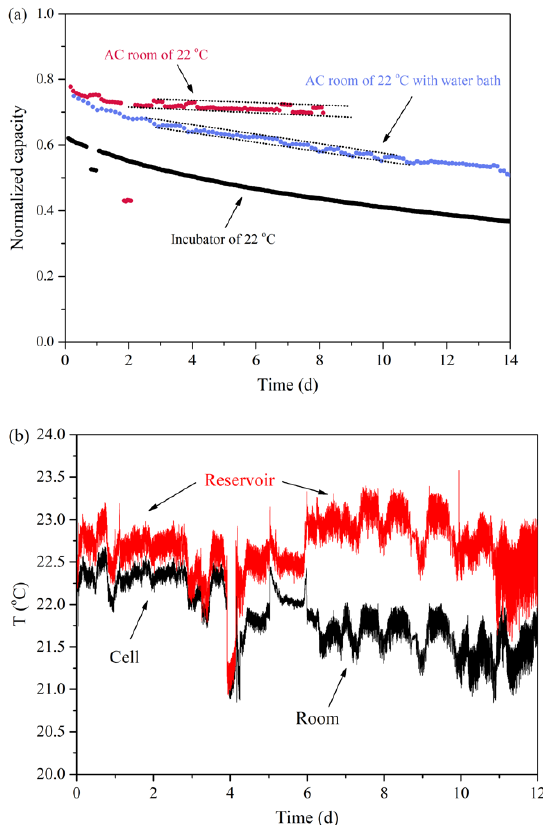
Figure A1. ( a ) Discharge capacity of a symmetric flow cell using the GS cycling method under different temperature control conditions; ( b ) temperature of the air-conditioned (AC) room, the cell setup and the electrolyte reservoir.